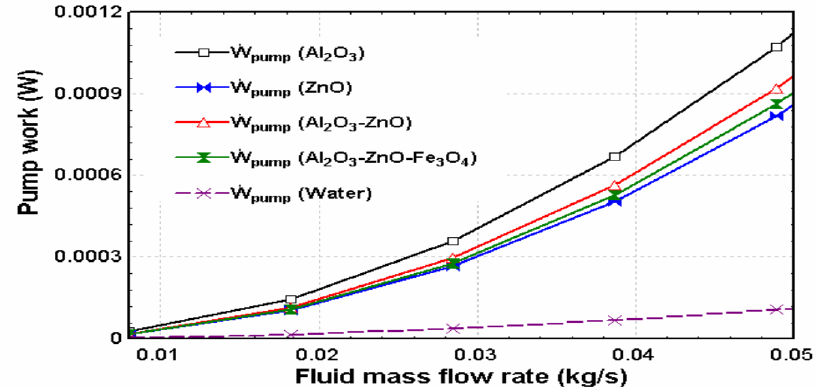
Figure 19. Pump work of heat transfer fluids.